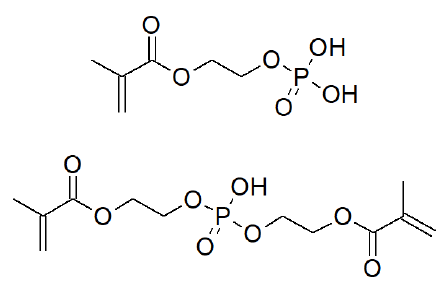
Figure 1. Chemical structures of monomers used: MEP ( top ) and BMEP ( bottom ) .